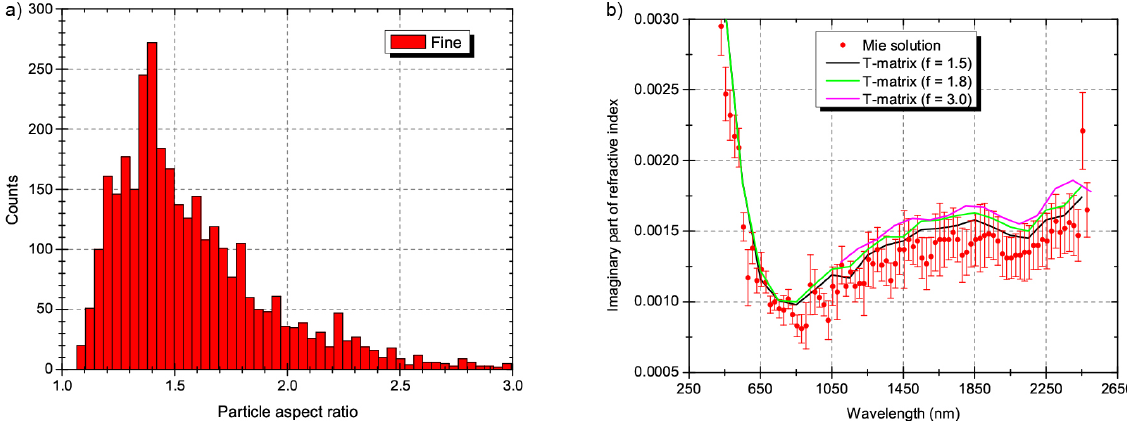
Figure 13. (a) Particles’ shape distribution for the fine mode of the volcanic ash and (b) analysis of the imaginary part of the complex refractive index considering different aspect ratios f for the T-matrix calculations of spheroidal particles. For f = 3, the imaginary part of the complex refractive index was retrieved only for wavelengths above 1100nm due to convergence issues of the T-matrix code for shorter